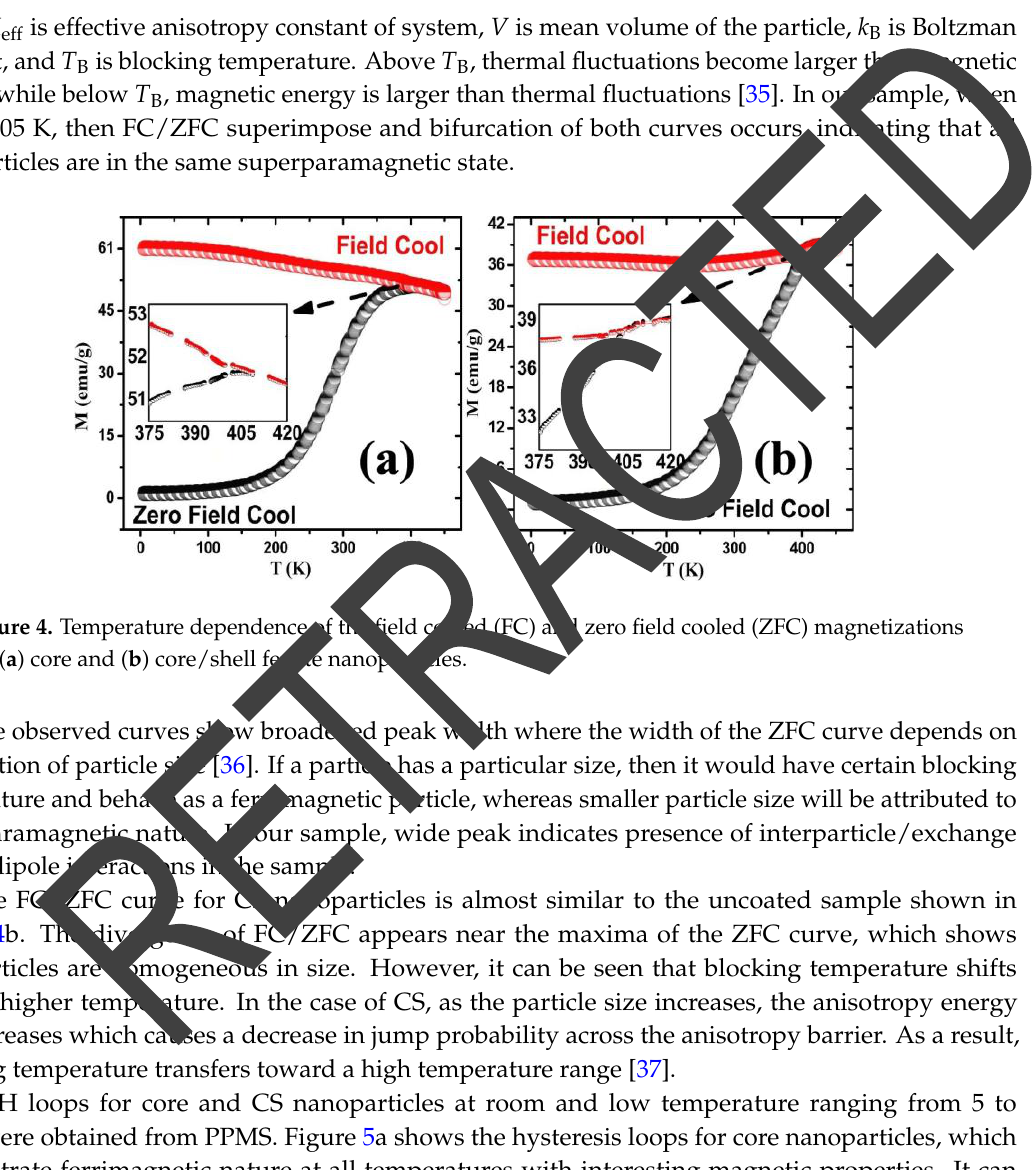
Figure 5. Magnetization curves recoded at different temperatures ranging from 5 to 300 K for ( a ) core and ( b ) core/shell sample.